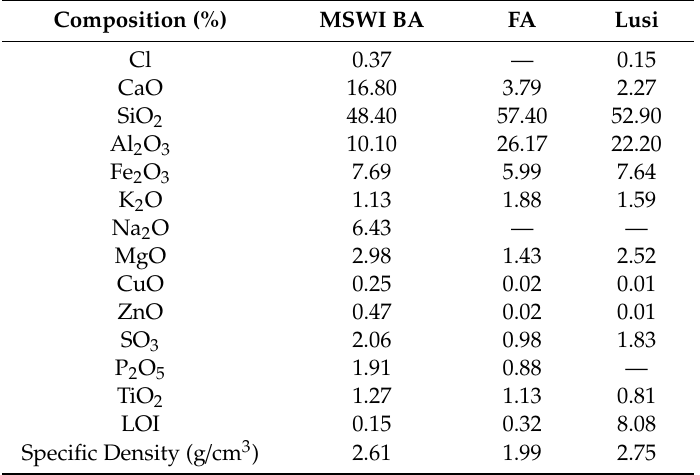
Table 3. Chemical Composition of the binders determined via X-ray